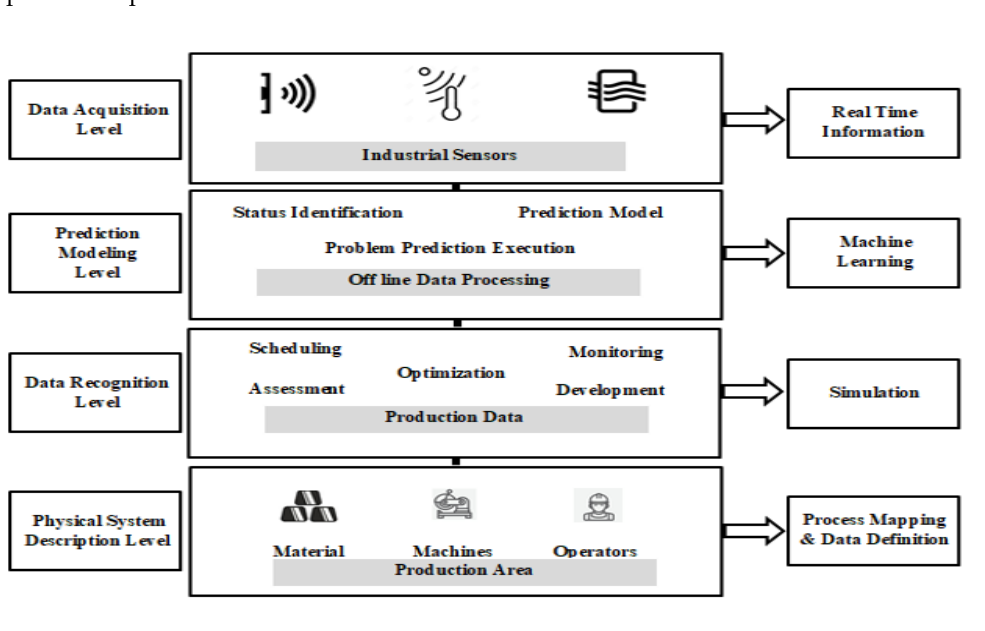
Figure 1. Proposed